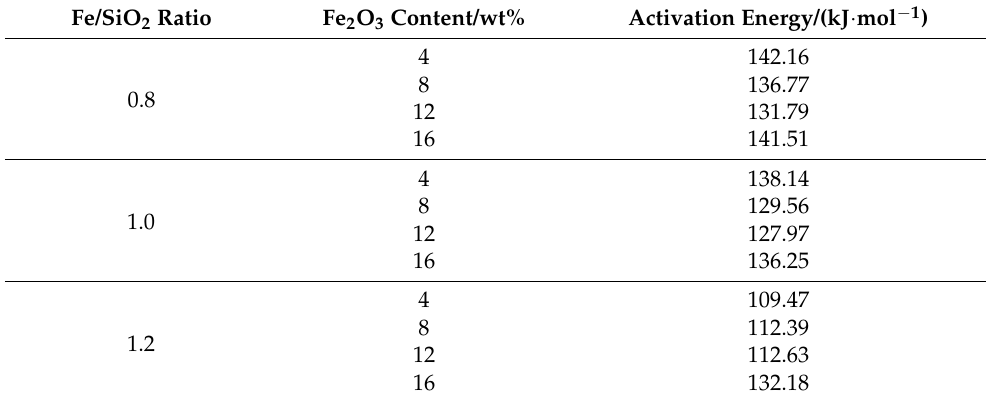
Table 3. E η values at different Fe/SiO 2 ratios and Fe 2 O 3